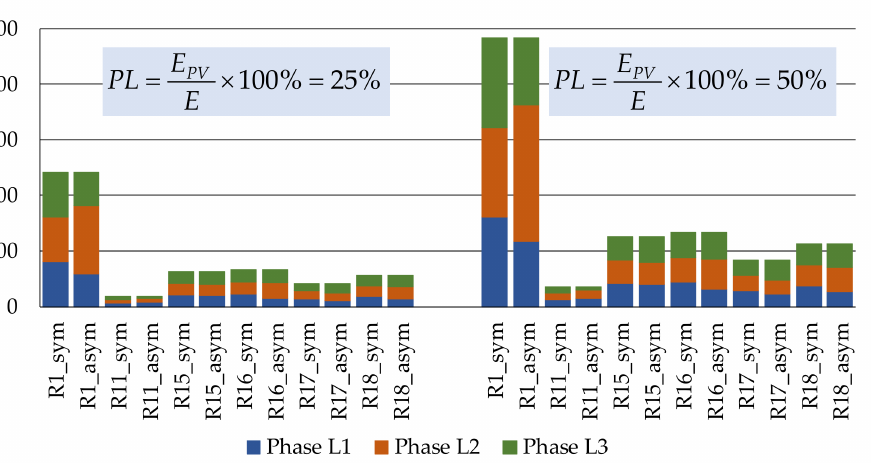
Figure 5. Division of the rated power of PV sources (kW) between the individual phases of the load buses in the CIGRE test